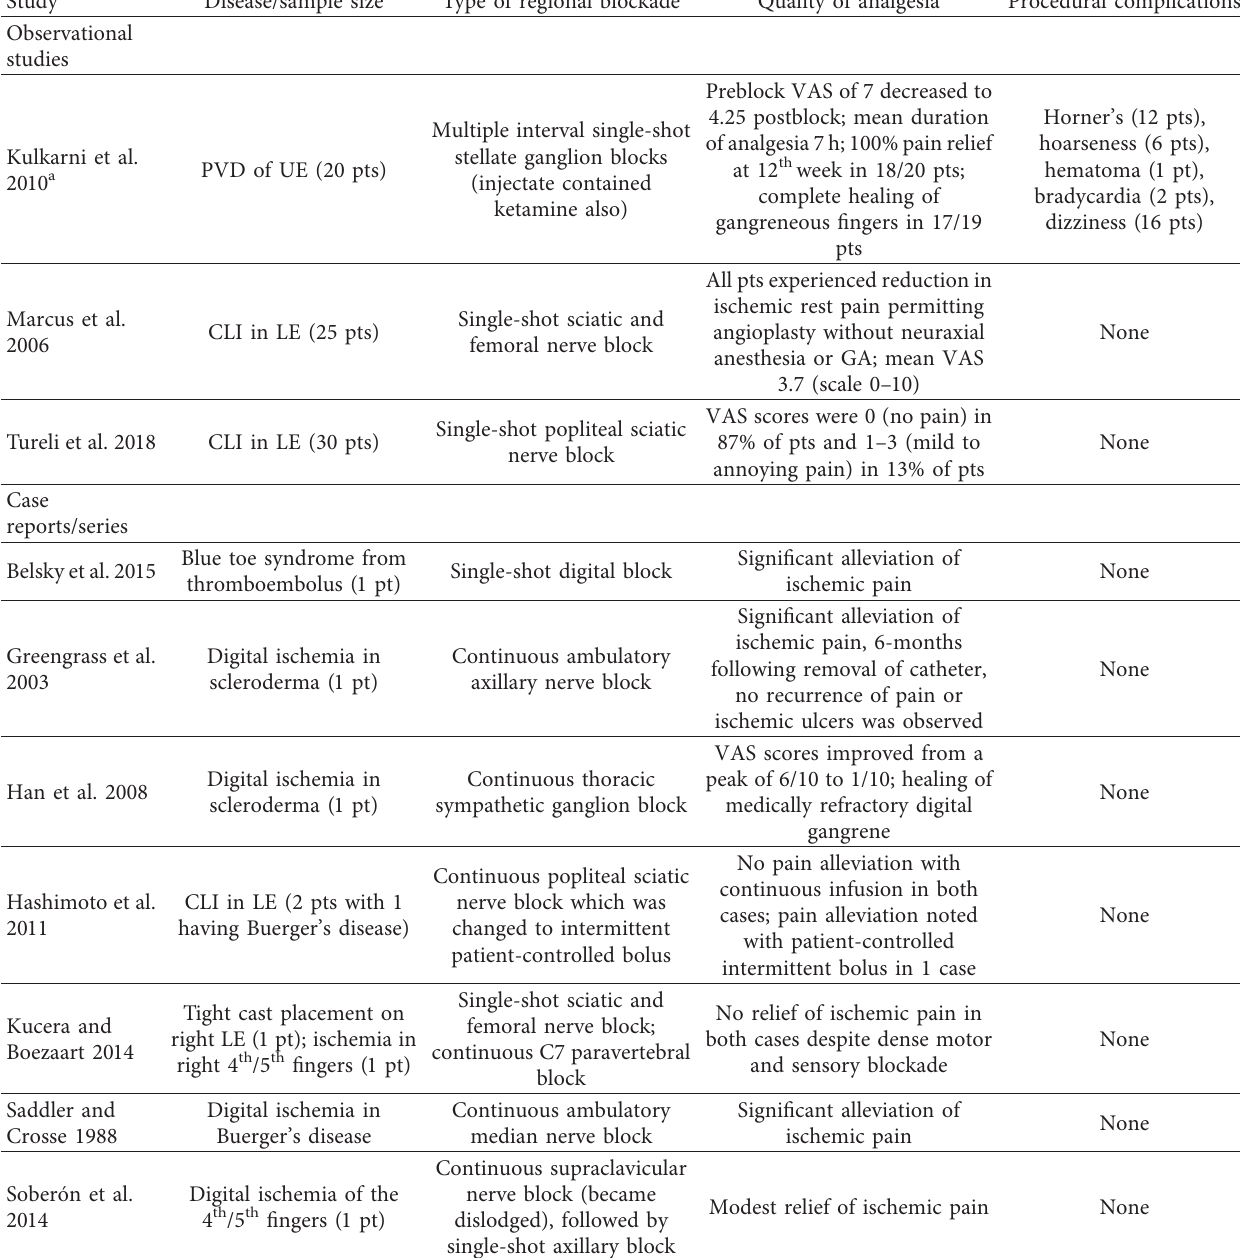
Table 1: Summary of findings from included